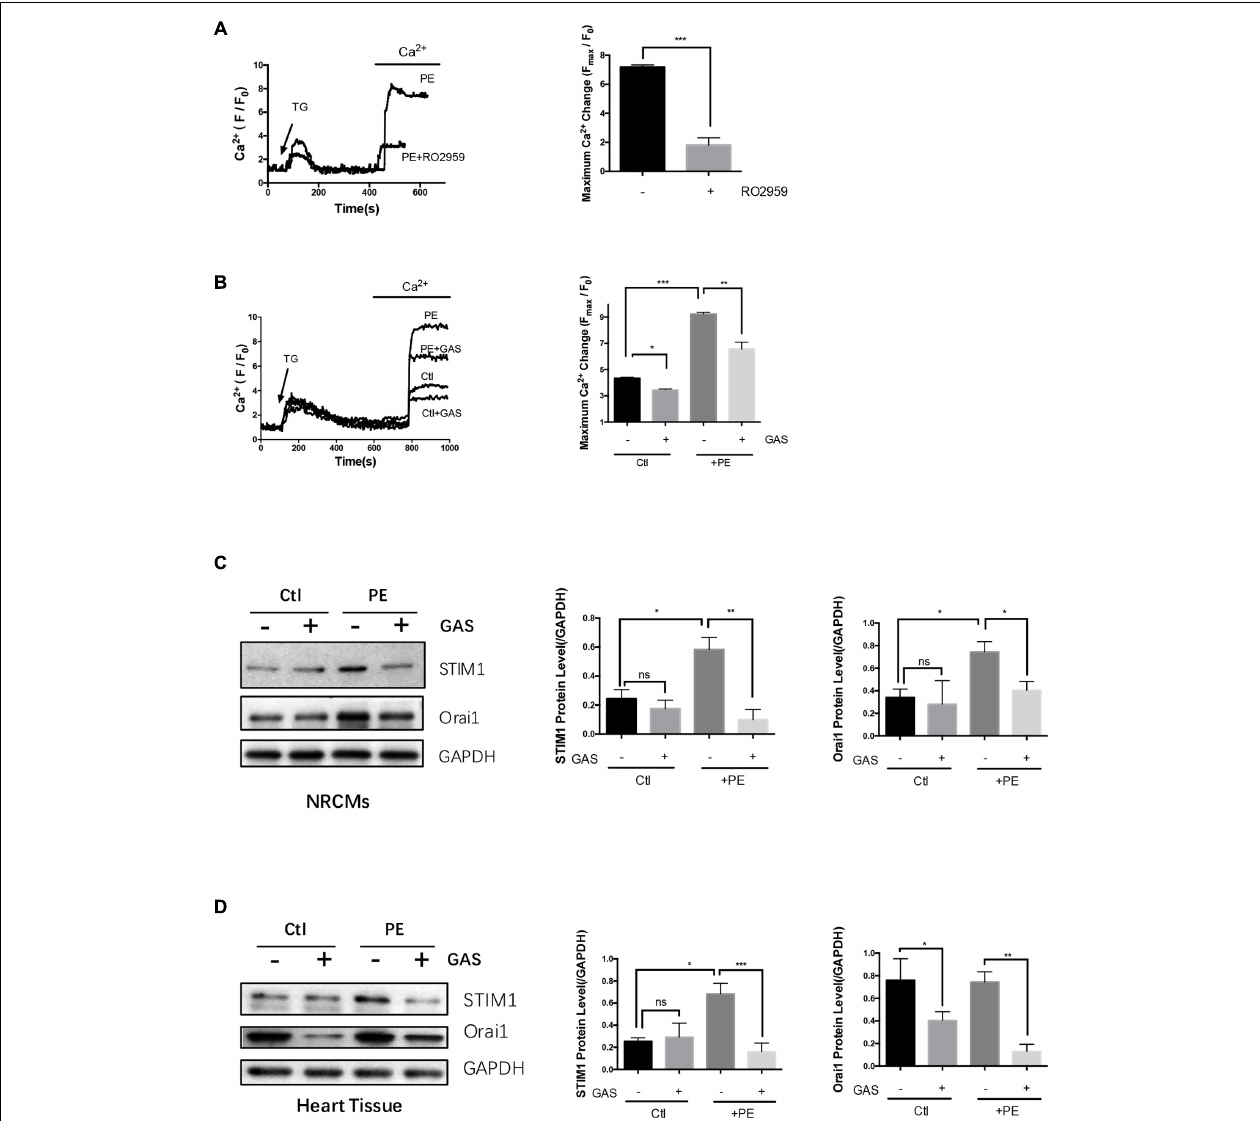
FIGURE 5 | Chronic gastrodin treatment inhibited SOCE and reduced the expression of STIM1 and Orai1. NRCMs were treated with 50 µ mol/L PE for 48 h to induce hypertrophy. (A) Acute effect of RO2959 on SOCE in phenylephrine-treated hypertrophic cardiomyocytes. The cells were treated with 4 µ mol/L thapsigargin (TG) in a Ca 2 + -free bath, which induced the first Ca 2 + rise, followed by adding back 1 mmol/L Ca 2 + to the bath, which induced the second Ca 2 + rise. The second Ca 2 + rise is due to SOCE. RO2959 at 5 µ mol/L was applied 5 min before TG. The representative traces (left) and data summary (right) of Ca 2 + responses are shown. Only SOCE is plotted in the summary chart. (B) Effect of chronic gastrodin treatment on SOCE. GAS at 100 µ mol/L was applied 12 h before PE. The control group (Ctl) did not undergo PE treatment. (C,D) Effect of gastrodin on the protein expression of STIM1 and Orai1 in NRCMs in vitro (C) and heart tissue in vivo (D) . The representative images (left) and data summary of immunoblots (right) are shown. GAPDH was used as the house-keeping control gene. The data are expressed as the mean ± SEM [ n = 5 repeats, > 15 cells per repeat in (A,B) ; n = 5 in (C,D) ]. ∗ p < 0.05; ∗∗ p < 0.01; ∗∗∗ p < 0.001. ns, not